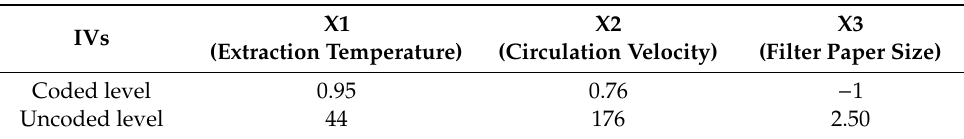
Table 6. Optimal conditions of reproducibility experiments (RE).